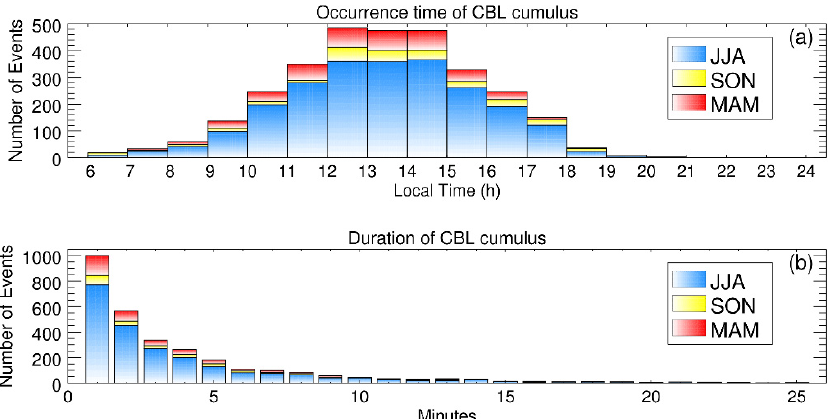
Figure 7. Distributions of ( a ) occurrence time (local time) and ( b ) duration time for a total of 3047 shallow cumulus cloud events observed from 2011 to 2019 at Wuhan, China. The blue bar, yellow bar, and red bar represent, respectively, the number of events in summer (June, July, and August), autumn (September, October, and November), and spring (March, April, and May). Note that the cumulus clouds formed mostly (>95%) during the period of 09:00–18:00 LT, while their duration mostly (>92%) ranged from 1 to 10 min.